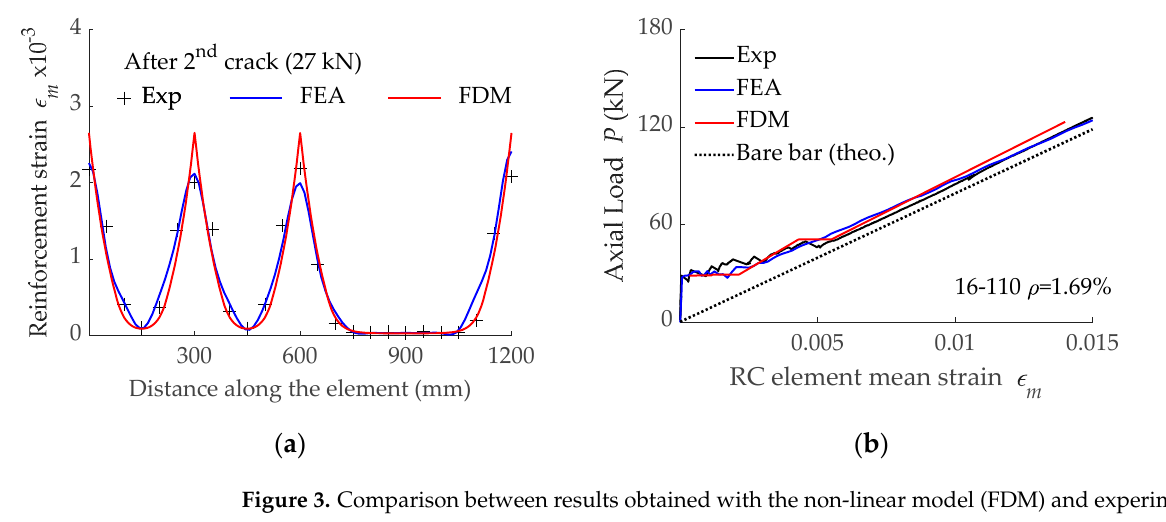
Figure 3. Comparison between results obtained with the non-linear model (FDM) and experimental (Exp) and numerical results using FEA: ( a ) Distribution of reinforcement strain after formation of the second crack in specimen 16-170-3N; ( b ) Load-mean strain curves for specimen 16-110.